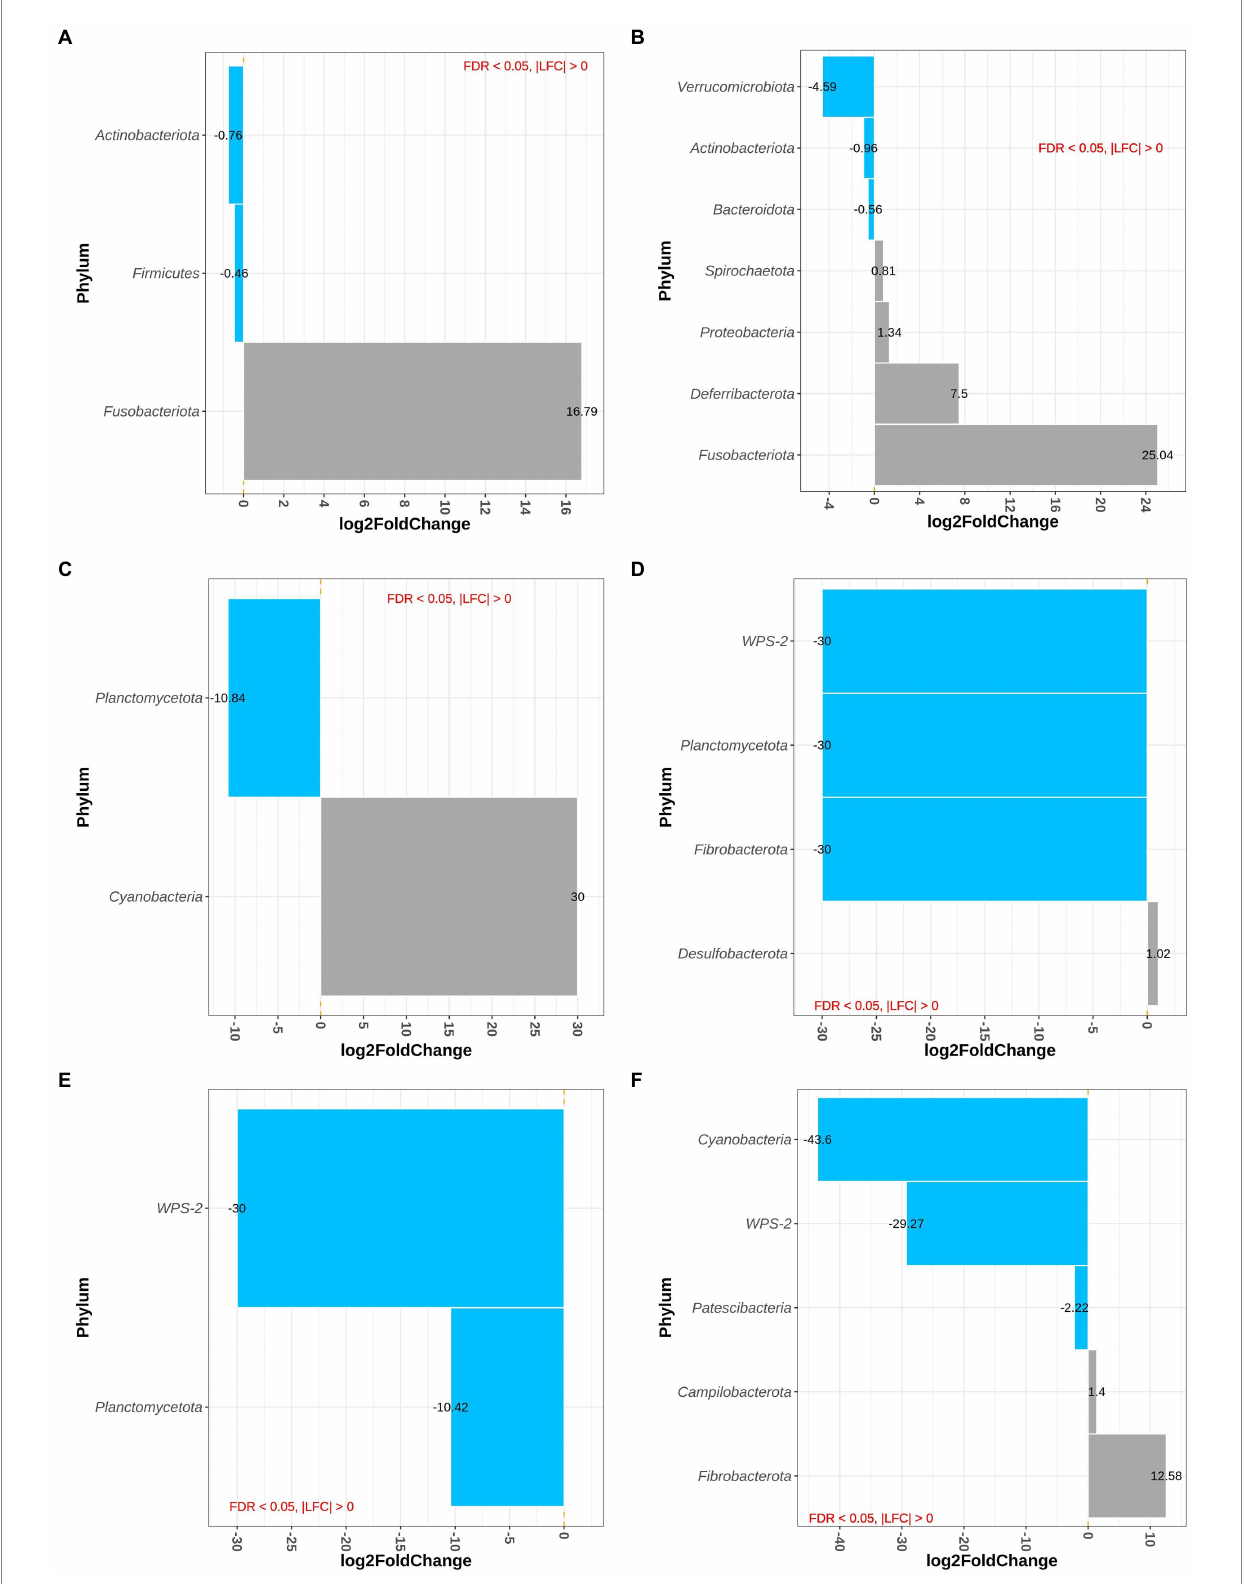
FIGURE 3 Differentially abundant Phyla for the main effect of diet (westernized diet groups vs. non-westernized group; A ) and DexSS (DexSS groups vs. non- DexSS groups; B ), and pairwise comparison for phyla with significant interaction for WD vs. CT (C) , DSS vs. CT (D) , WDDSS (WD + DSS) vs. CT (E) , and WDDSS (WD + DSS) vs. WD (F) with FDR <